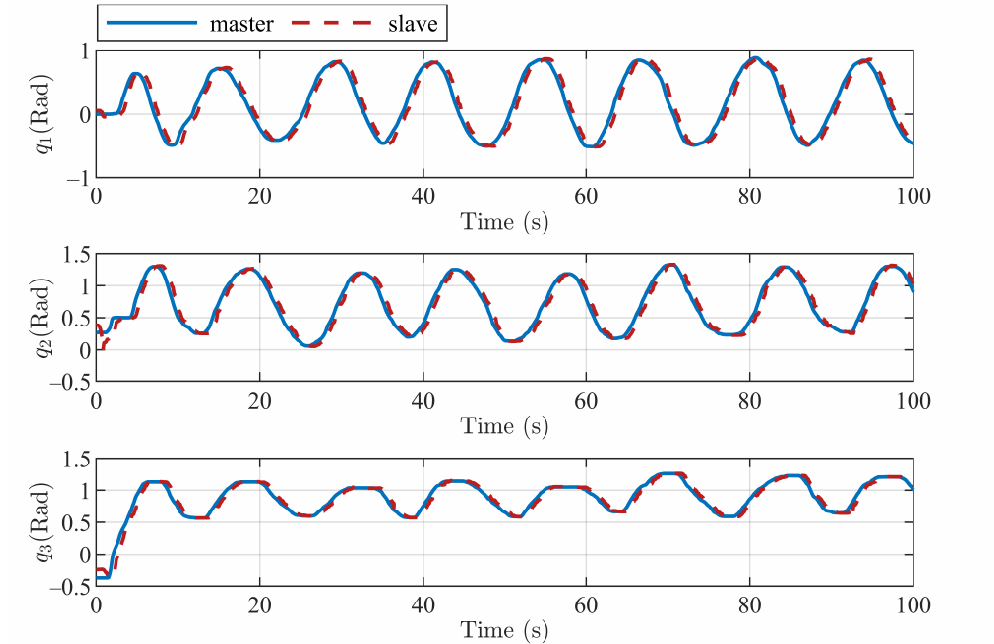
Figure 11. Tracking control performance of three active joints of master and slave robots based on the proposed